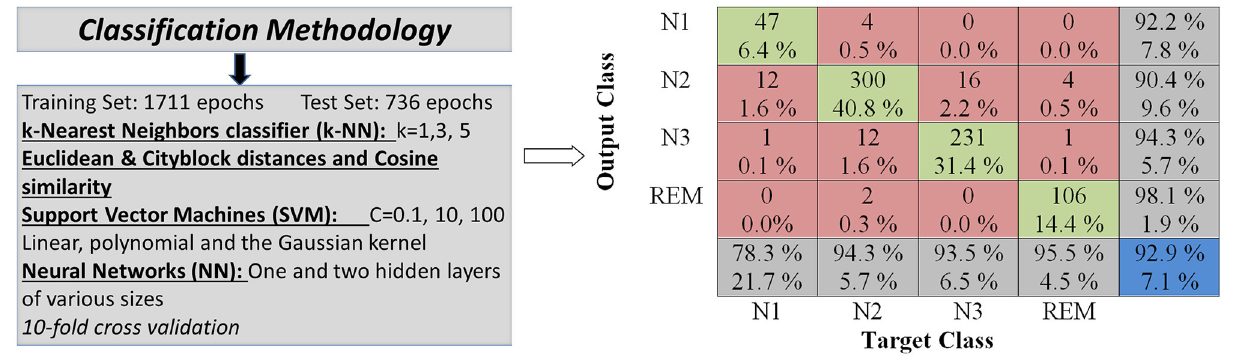
Three different kernels where evaluated using SVM classifiers. TABLE 3 | Confusion matrix for the Gaussian kernel SVM classifier ( σ